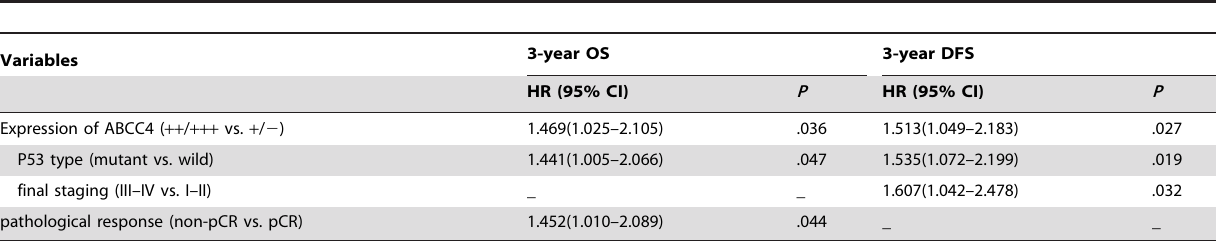
Table 2. Multivariate Cox Regression Analysis of Predictive Factors for Long-Term Prognosis in 121 LARC Patients Treated with Preoperative